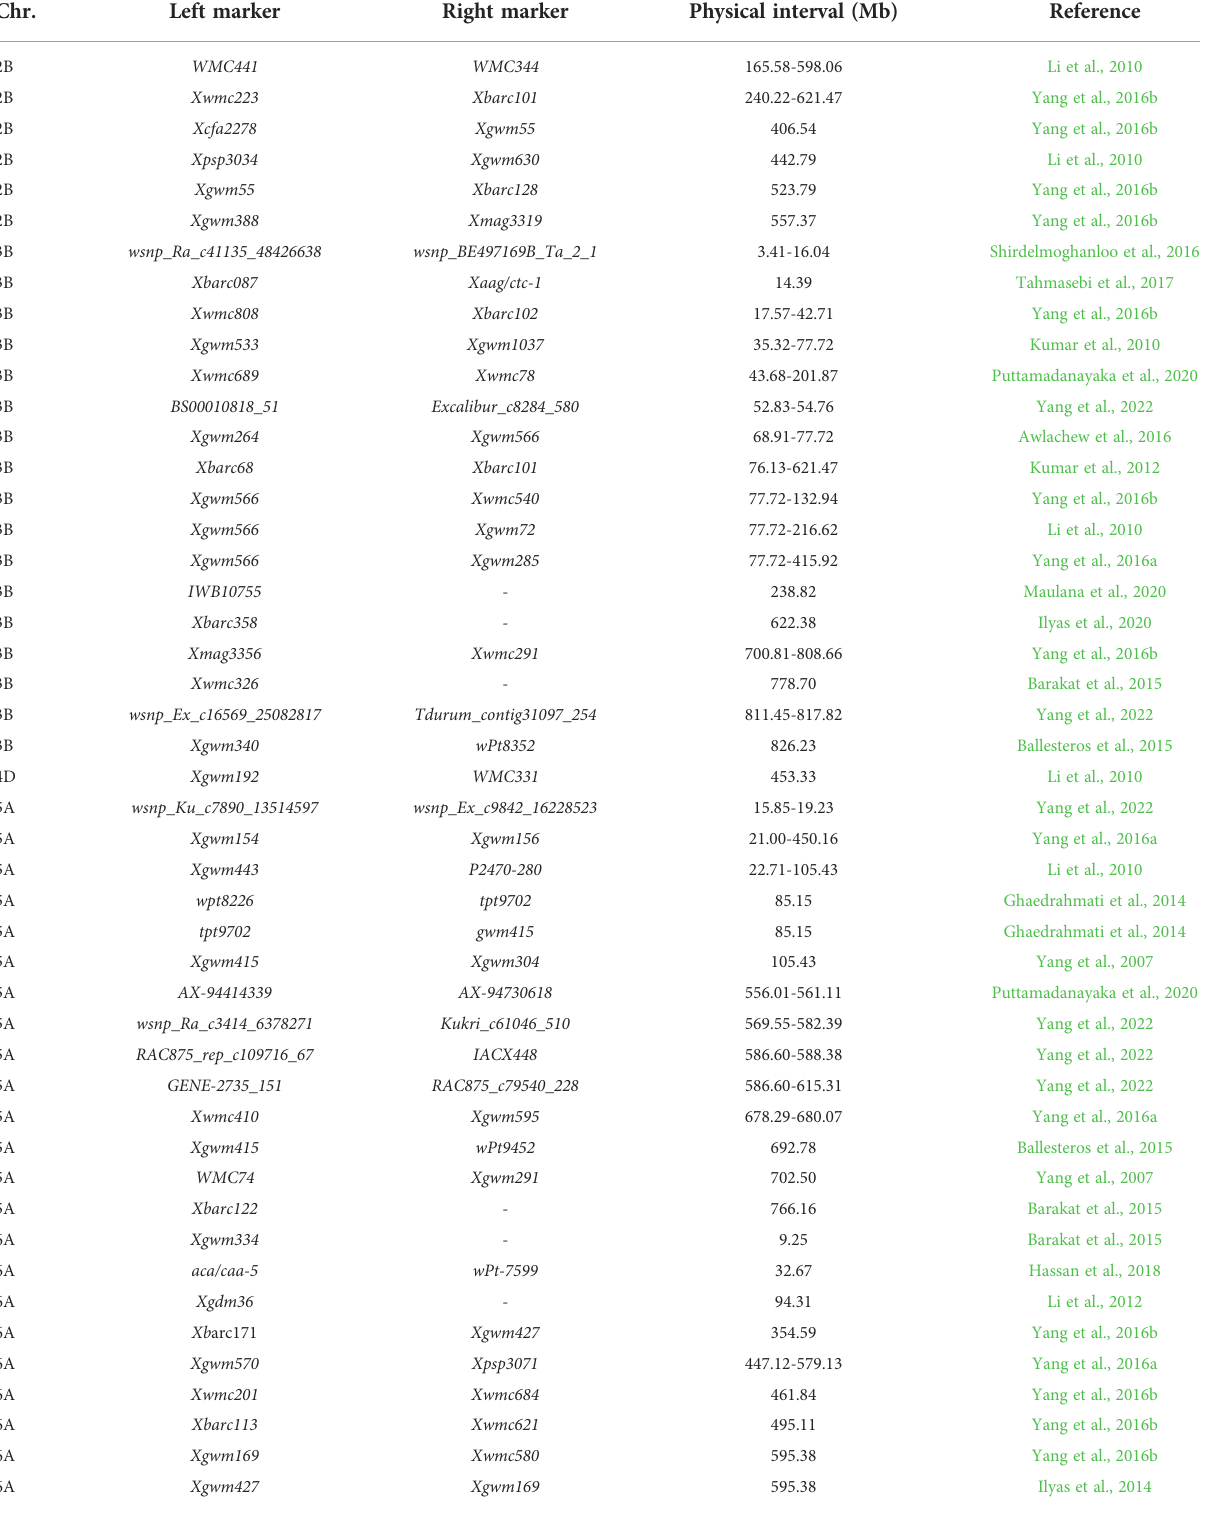
TABLE 6 Chlorophyll QTLs on chromosomes 2B, 3B, 4D, 5A, and 6A from previous studies.